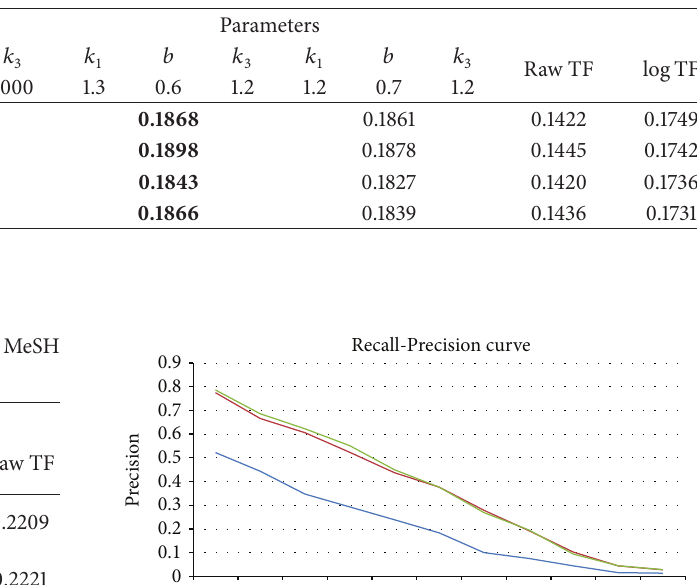
Table 6: MAP values for the TF-IDF BM25, Raw TF, and log TF formulas.